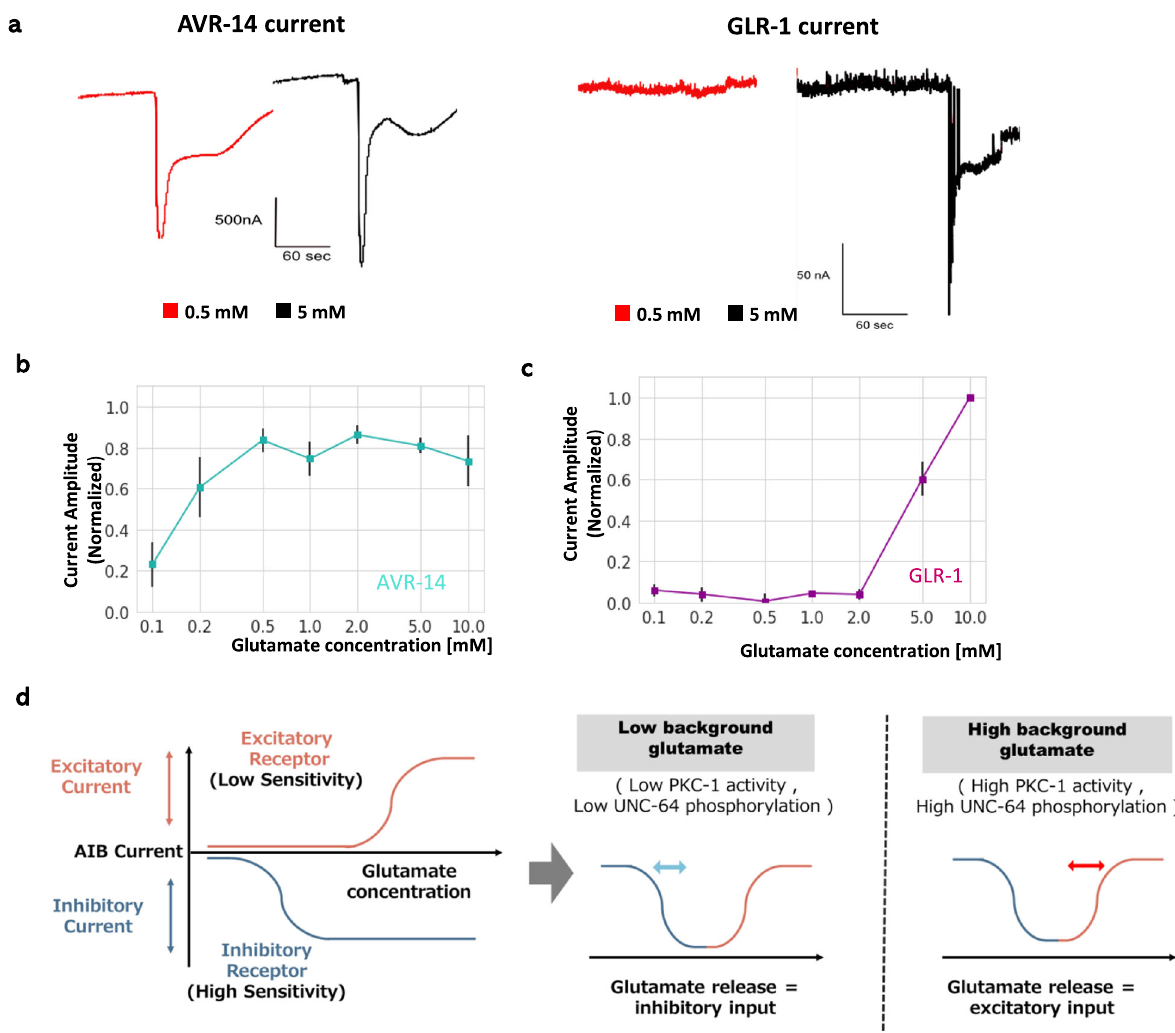
Fig. 7 The differential sensitivity between the excitatory and inhibitory glutamate receptors, which leads to reversal of postsynaptic response. a Examples of the current response to 0.5 and 5 mM glutamate. When the oocyte was clamped to − 50 to − 60 mV, both chloride and cation (mainly sodium) currents were observed as inward currents 37 – 40 . While the response to 0.5 mM glutamate is comparable to that to 5 mM glutamate in AVR-14- expressing oocytes, almost no current was observed in GLR-1( + STG-1, SOL-1)-expressing oocytes in response to 0.5 mM glutamate. b Dose-response relationship between glutamate concentration and normalized current in AVR-14-expressing Xenopus oocyte. n = 5 independent oocytes. c Dose-response relationship of GLR-1-expressing Xenopus oocyte. Functional GLR-1 glutamate receptor was reconstituted by expressing glr-1 along with auxiliary proteins, sol-1 and stg-1 38 . n = 5 independent oocytes. d Schematic illustration of the bidirectional response of AIB to glutamate via excitatory and inhibitory receptors with different sensitivities. When these receptors have different sensitivity ranges (left), the total current is expected to become well-shaped, where depending on basal level of glutamate the postsynaptic response to additional glutamate becomes either inhibitory (middle) or excitatory (right). The vertical lines in b , c show SEM. Source data are provided as a Source Data fi